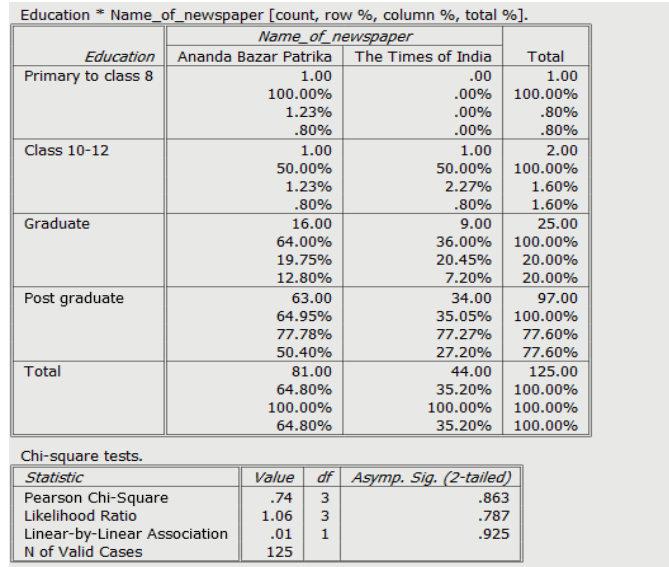
Figure 8: Cross tabulation and Chi-square between Education v/s Newspaper Read (Source: Authors‟